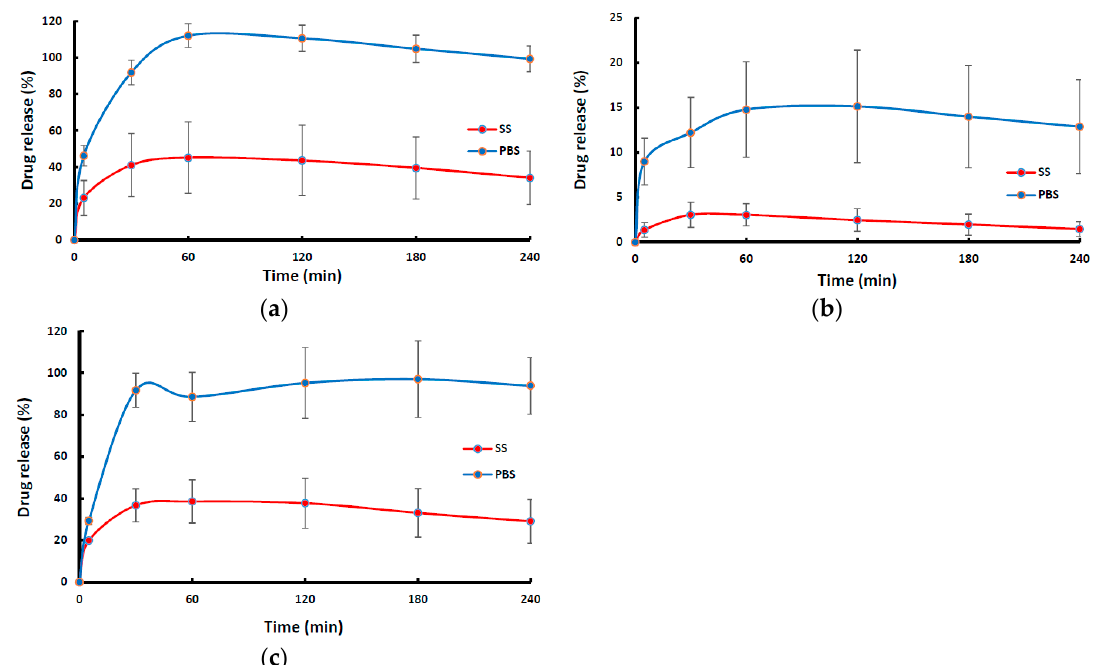
Figure 5. In vitro drug release profile ( n = 3, ± SD) of NIC from formulations; ( a ) MAS wafer, ( b ) MAS film, and ( c ) non-MAS wafer, in SS and PBS.